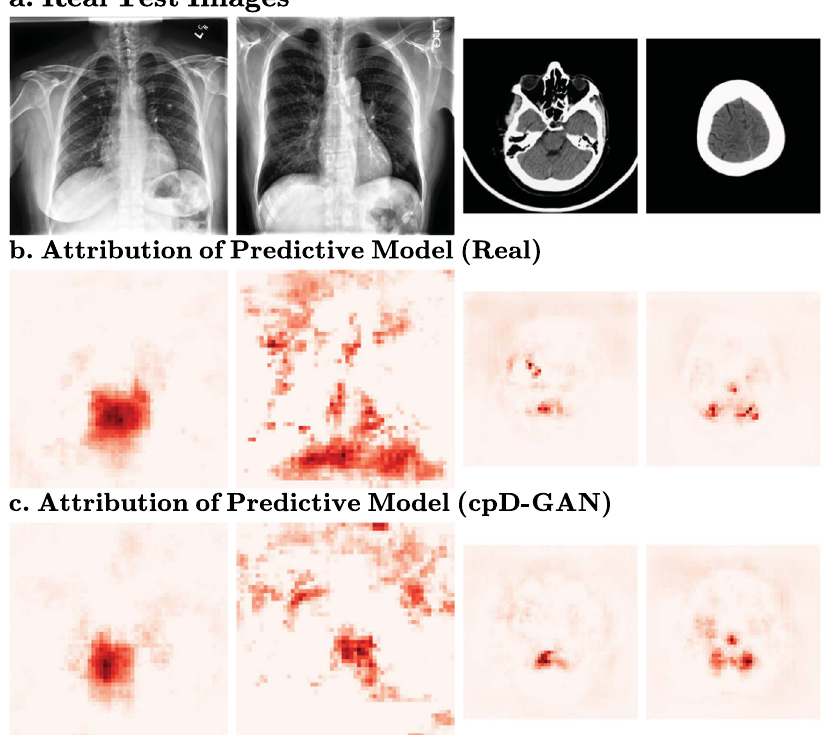
Fig. 6 Feature importance of predictive models trained on cpD-GAN synthetics Deeper red colour indicates regions that have a larger causal contribution to the label prediction. a Nearest neighbours from Fig. 4 and Supplementary Fig. 2, (512 × 512 pixels for chest X-rays, 256 × 256 pixels for brain CT scans). From left to right: (1) Chest X-ray with no fi nding. (2) Chest X-ray with cardiomegaly, atelectasis and support device. (3) Brain scan with no fi nding. (4) Brain scan with intraventricular haemorrhage. b Feature importance of predictive model trained on real data. c Feature importance of predictive model trained on synthetic data generated by the